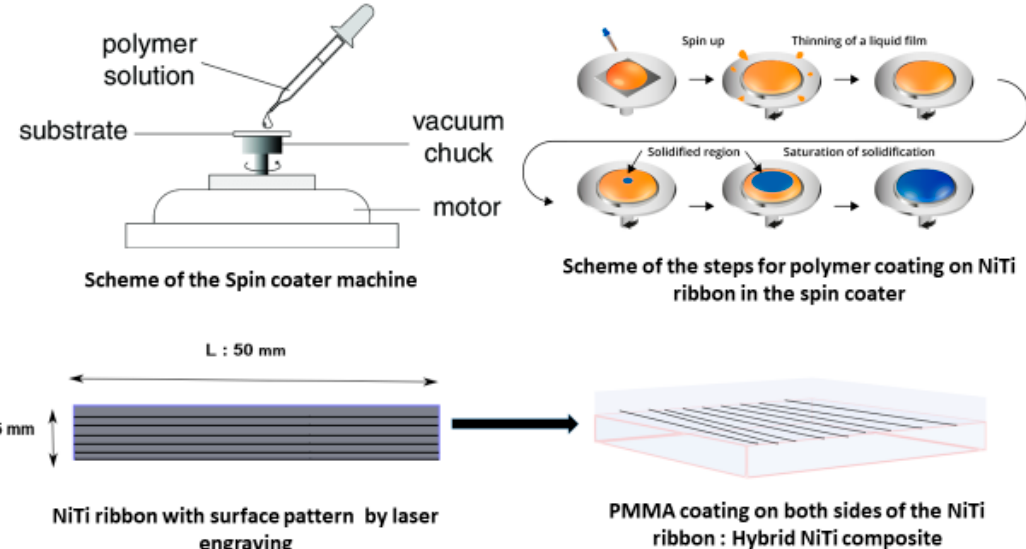
Figure 4. Scheme of the Ni-Ti ribbon with channels and poly (methyl methacrylate) (PMMA) polymer by spin coating.